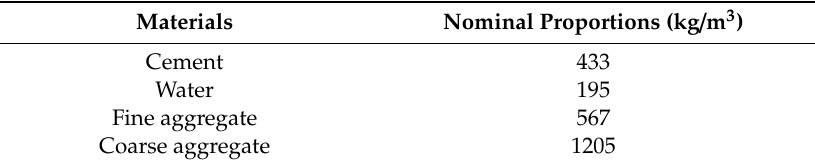
Table 1. Mixture proportions of concrete.